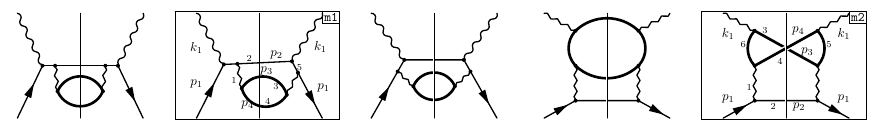
Figure 1. Diagrams contributing to the total cross section of the e − γ → e − µ + µ − process. First three diagrams correspond to C -odd muon pair, while the last two diagrams — to C -even